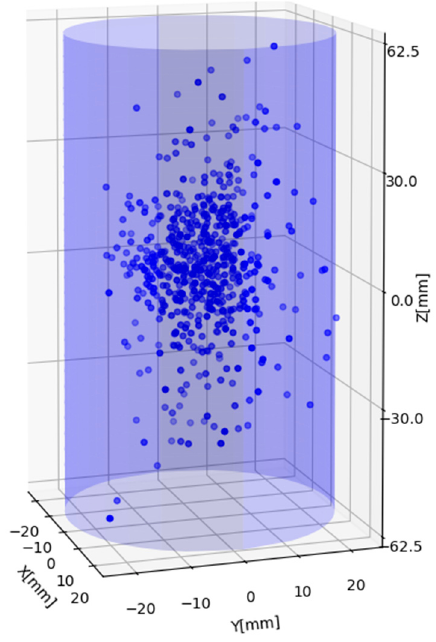
Figure 11. Acoustic emission events positioning results.